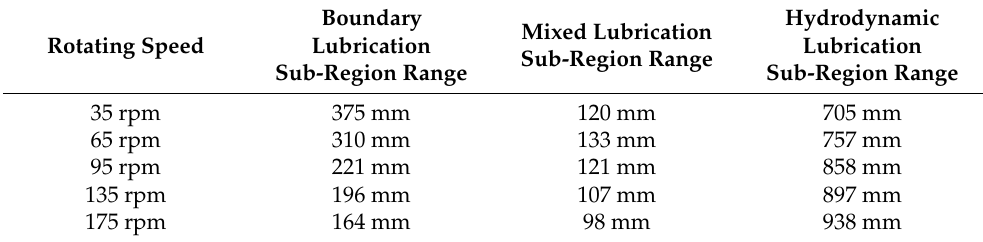
Figure 15. Minimum film-thickness distribution along the axial direction at each speed. Table 4. Lubrication sub-region range at each